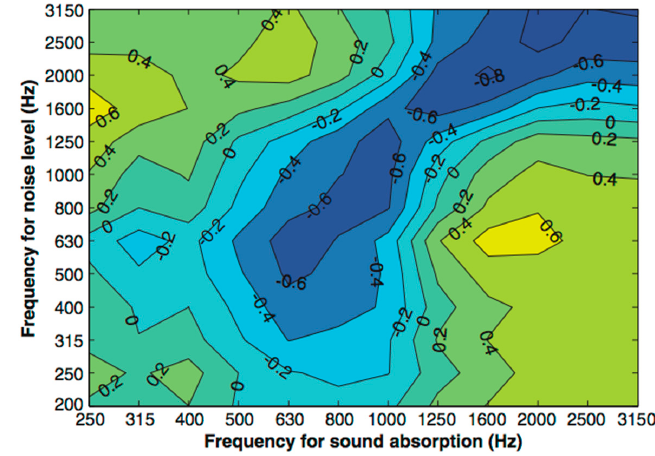
Figure 27. Contour lines of the correlation coefficient between noise level (passenger car tire at 80 km/h) and sound absorption coefficient (source from Li et al., 2015 [193], Figure 6; reprinted with permission from American Society of Civil